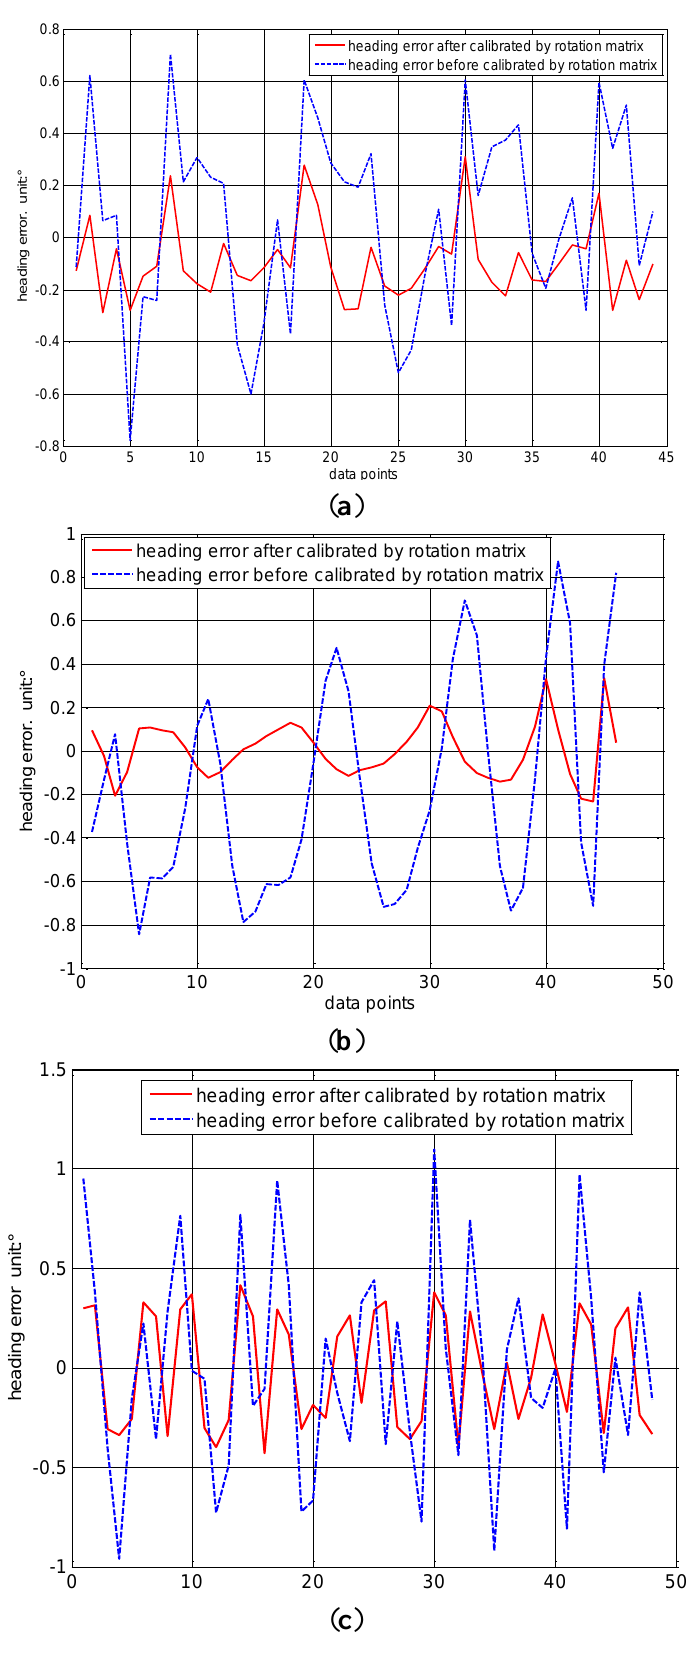
Figure 8. ( a ) Experiment results comparing heading error in Beijing suburbs; ( b ) experimental results comparing heading error in laboratory in the city; and ( c ) more experimental results comparing heading error in the laboratory in the